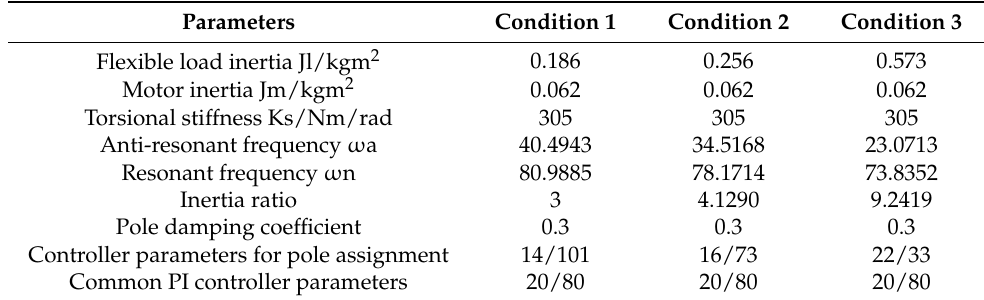
Table 1. Parameters of the dual-flexible manipulator.